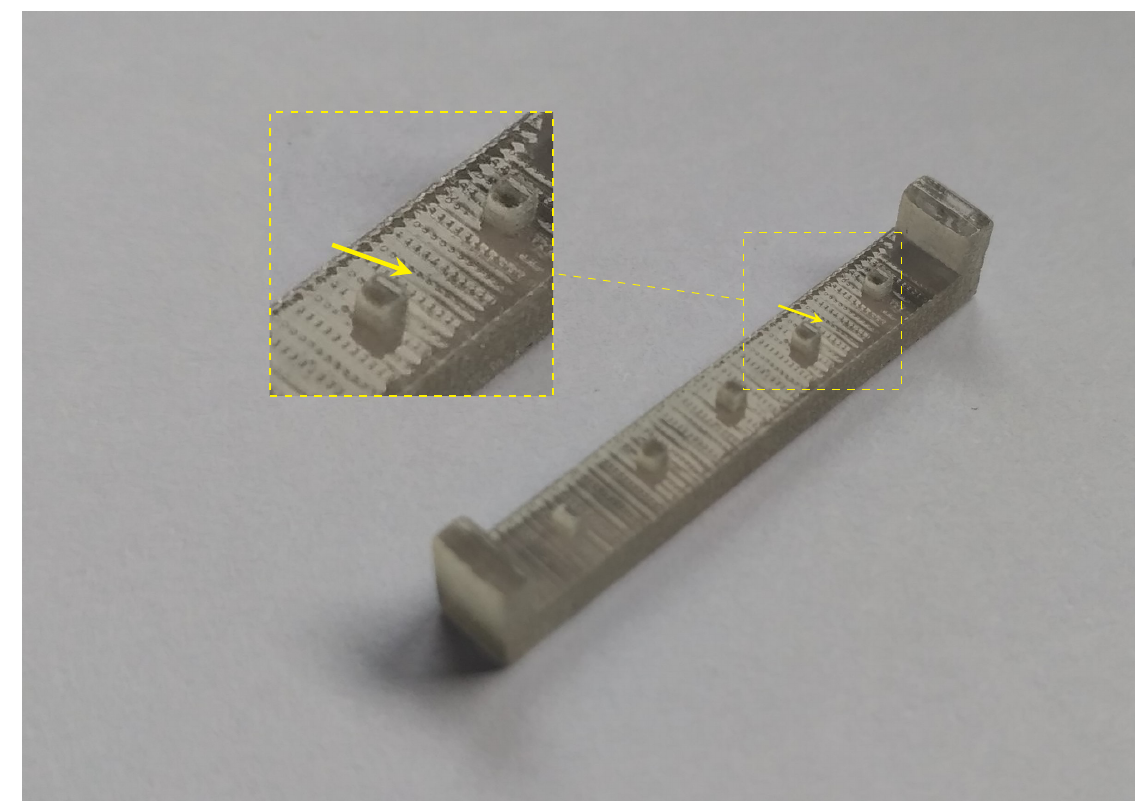
Figure 12. ST detail with highlighted marks/grooves on the top